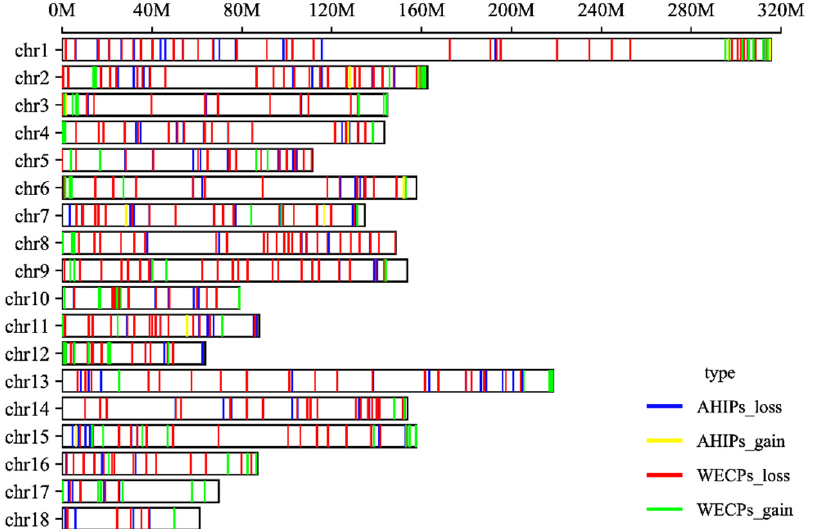
Figure 2. Genomic distribution and status of CNVRs in pig autosomes. The locations of 604 CNVRs are shown on the autosomes in blue (AHIPs_loss), yellow (AHIPs_gain), red (WECPs_loss), and green (WECPs_gain). Y-axis values are chromosome names, and X-axis values are chromosome position in Mb, which are based on the Sscrofa 10.2 reference genome assembly.